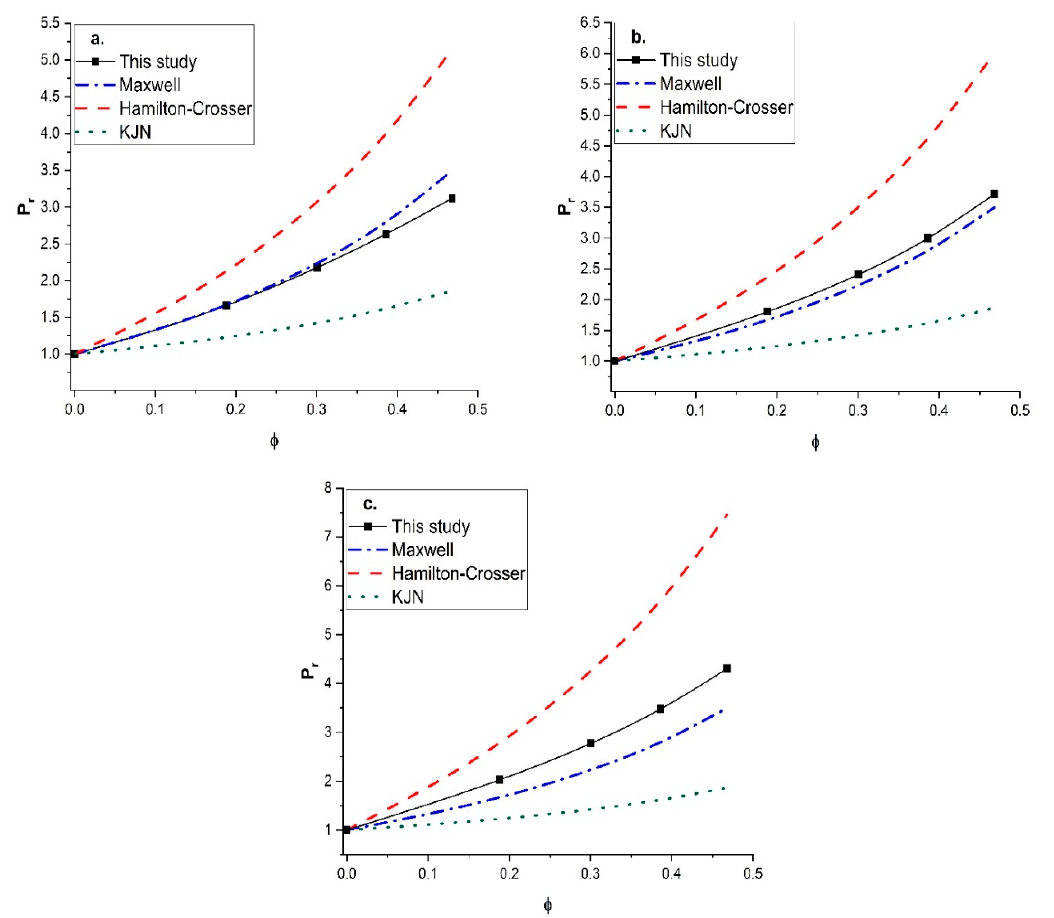
Figure 12. Comparison of the predicted relative permeability obtained in this study with the Maxwell, Hamilton—Crosser, and KJN models as a function of the nanotube volume fraction for ( P d / P c ) = 100: ( a ) α = 10, ( b ) α = 20, and ( c ) α = 50.